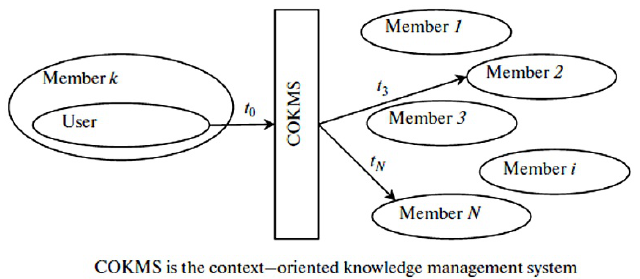
Fig. 8. Interaction with context-oriented knowledge